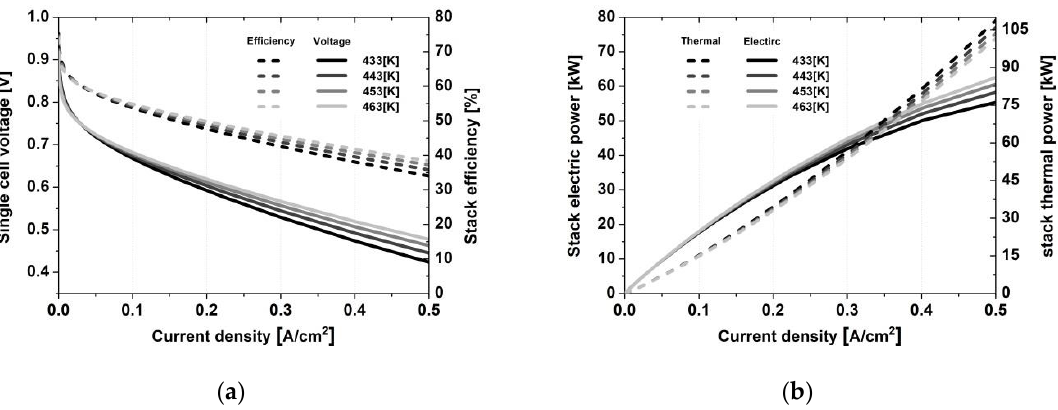
Figure 6. HT-PEMFC performance curve according to stack temperature and current density. ( a ) Single cell voltage and stack power efficiency; ( b ) Stack electric power and thermal power.